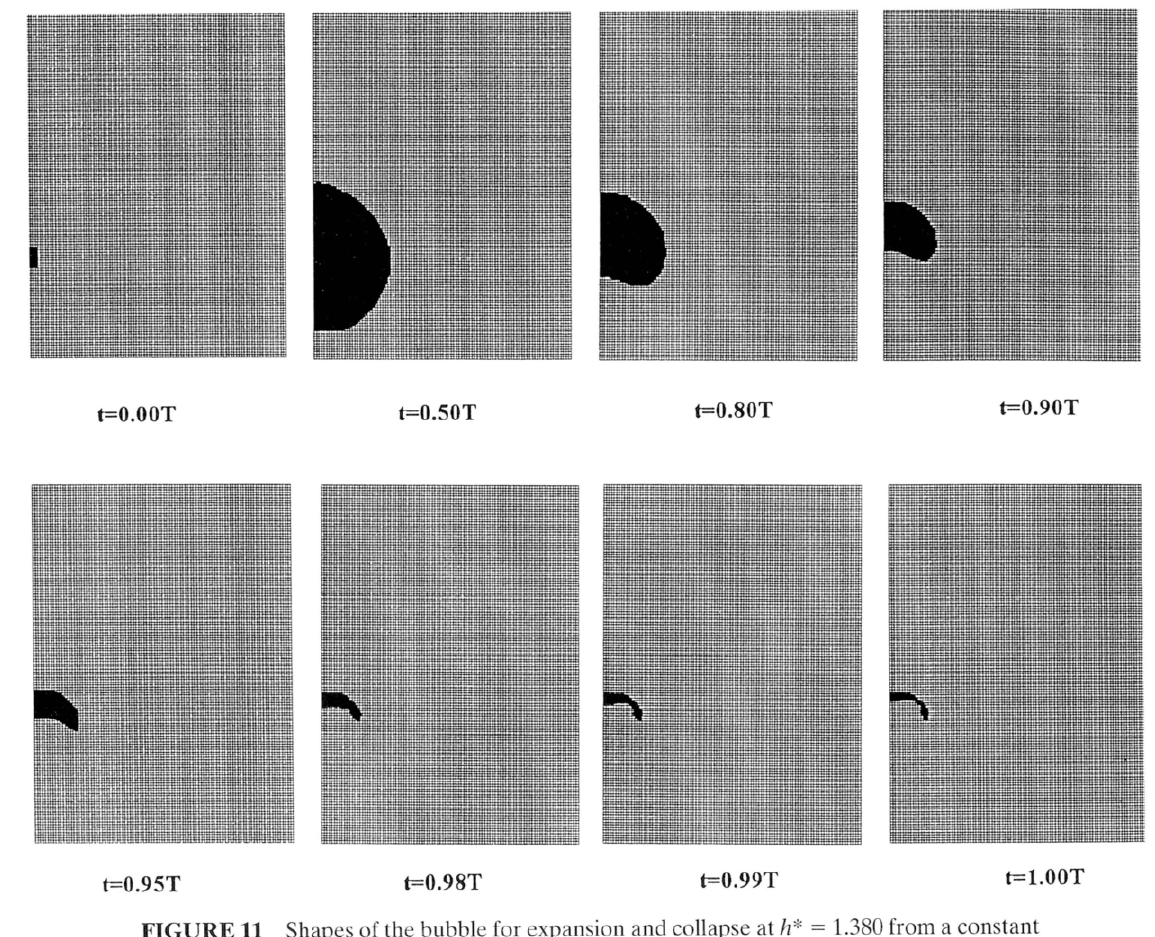
FIGURE 11 Shapes of the bubble for expansion and collapse at h* = 1.380 from a constant pressure boundary for the bubble near the boundary problem (boundary located at the